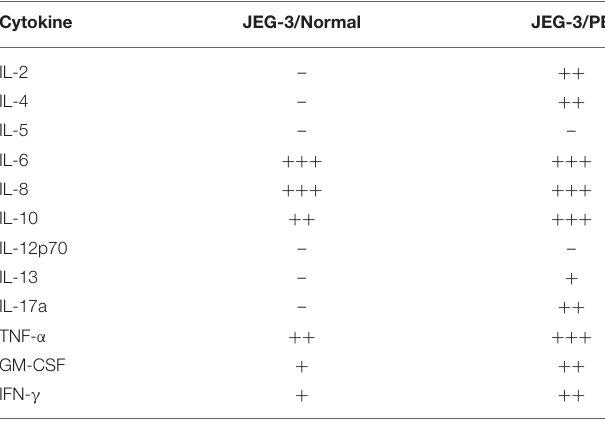
TABLE 2 | Analysis of the cytokine profile in the supernatants of lymphocyte cell cultures derived from peripheral blood mononuclear cells (PBMCs) from normotensive control and pre-eclamptic women (PE), stimulated with endoplasmic reticulum aminopeptidase (ERAP)1/ERAP2-expressing JEG-3